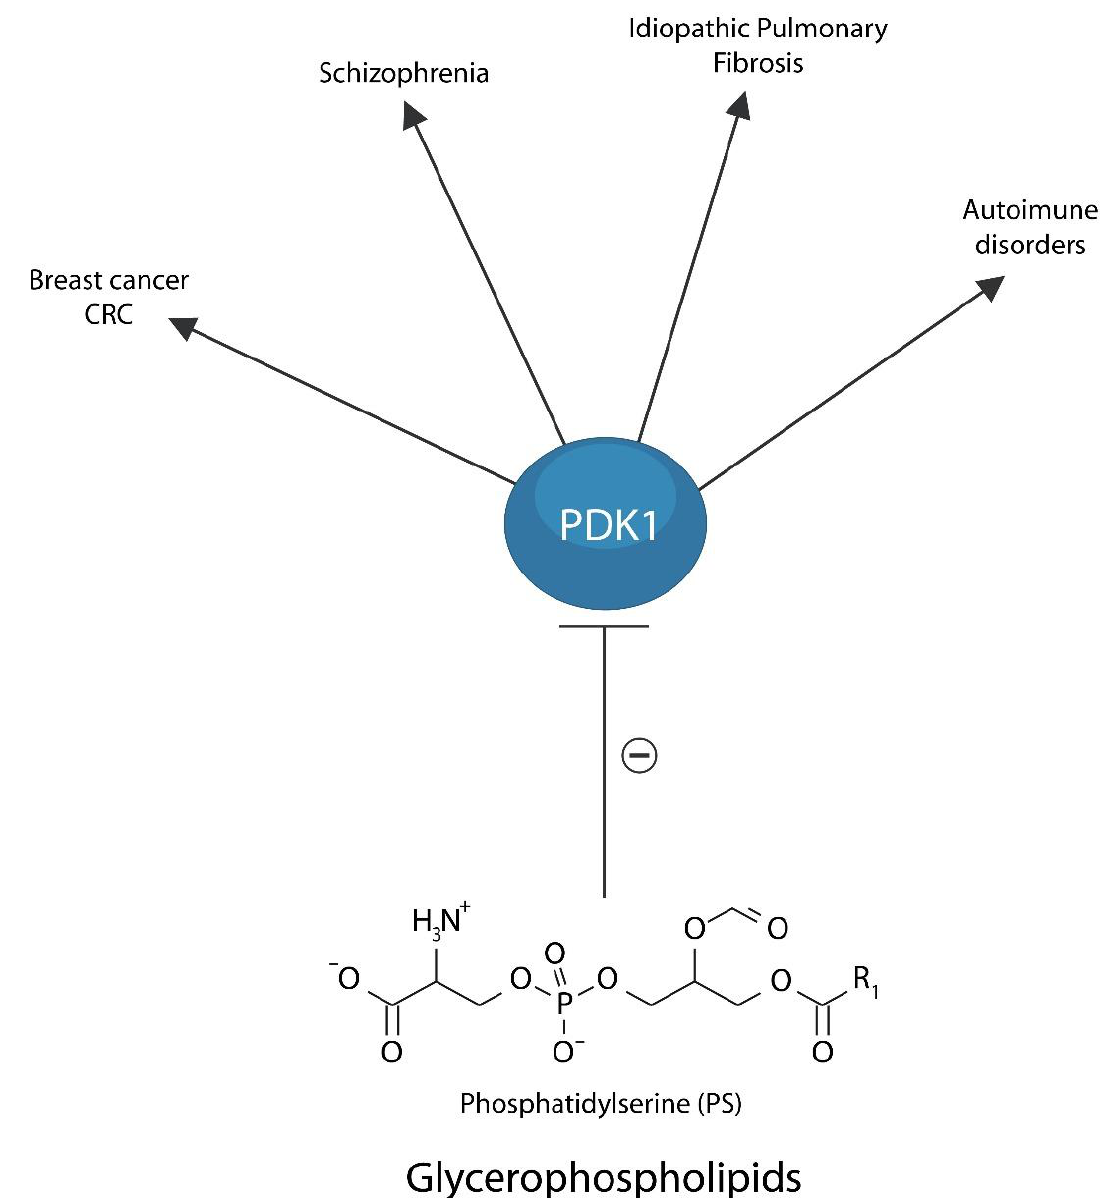
Figure 4. Membrane Lipid Replacement therapy with dietary glycerophospholipids maintains PDK1 in an inactive conformation, preventing its detrimental action in breast cancer and CRC, neuropsychiatric illness, including schizophrenia, pulmonary fibrosis, and autoimmune disorders. This model suggests that membrane lipid replacement therapy is likely beneficial for disorders of unclear